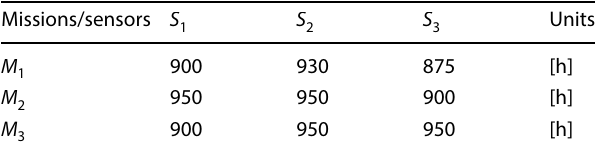
Missions/sensors S